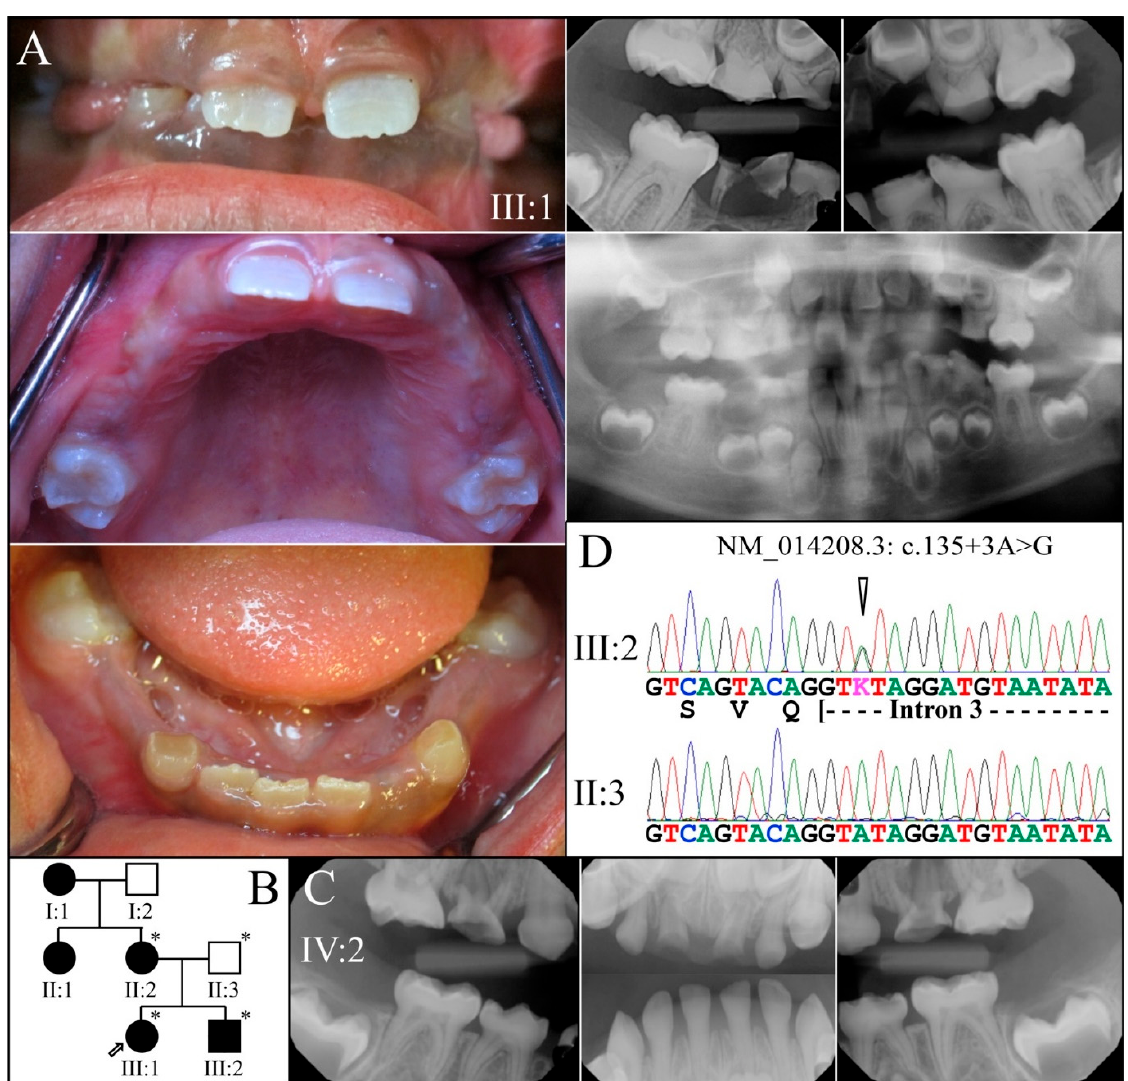
Figure 7. Family 4 from the USA. ( A ): The erupting permanent teeth of the proband (III:1) at age 6 were not as discolored as the primary teeth, but their enamel was very thin. Radiographs showed the primary teeth had fully obliterated pulp chambers and severe occlusal attrition. ( B ): The pedigree showed a dominant pattern of inheritance. ( C ): Radiographs of the affected younger brother (III:2) at age 3 (primary dentition) showed near pulp obliteration in the mandibular anteriors, and severe attrition in the maxillary second molars (both abscessed) and maxillary central incisors. ( D ): The enamel of the primary dentition was either very thin or not detectable on radiographs. The dental condition was segregated with a DSPP splice junction defect (NM_014208.3: c.135+3A>G). Key : * denotes enrolled participants.